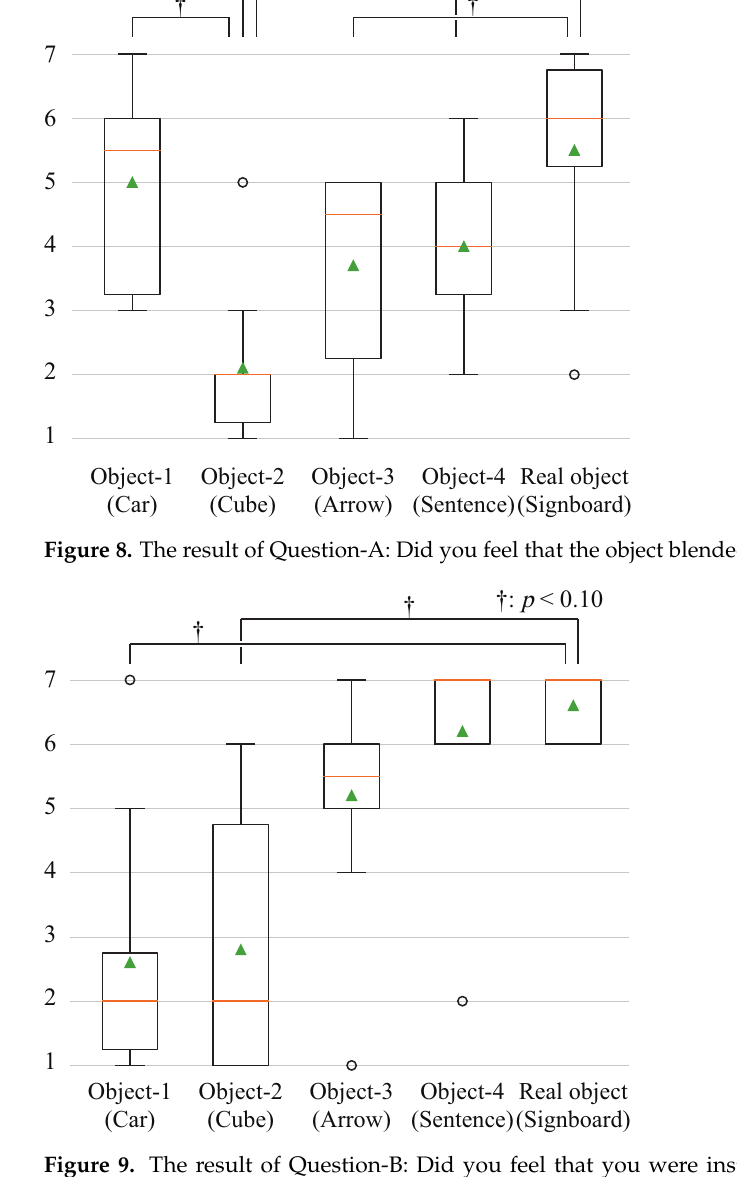
Figure 9. The result of Question-B: Did you feel that you were instructed to go to a particular direction by the